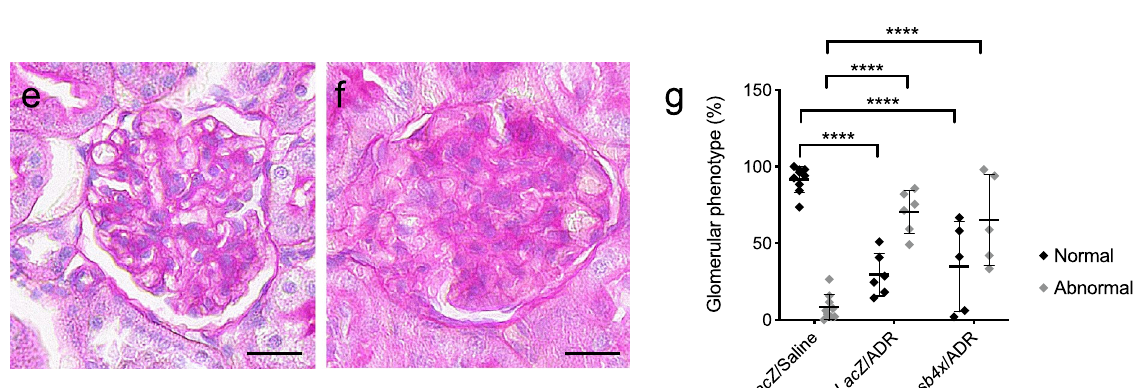
Figure 3. Renal function following ADR/TB4 treatment. (a) Mouse weight change 2, 7 and 14 days after ADR/ vehicle injection. Statistical annotations (two way repeated measures ANOVA with Tukey post hoc test) using asterisk refer to comparison between LacZ /saline & LacZ /ADR. Annotations using hash refer to comparison between LacZ /saline & Tmsb4x /ADR. (b) Twenty-four hour urinary albumin excretion 0, 2 and 14 days after ADR/vehicle injection (two way repeated measures ANOVA with Tukey post hoc test). (c) Correlation of plasma TB4 concentration with urinary albumin 14 days after ADR injection (Linear regression, R 2 = 0.4584, P ≤ 0.05). (d) Blood urea nitrogen concentration 14 days after ADR/vehicle injection (one-way ANOVA with Tukey post hoc test). Representative images of normal (e) and abnormal (f) glomeruli used to assess glomerular morphology, scale bar = 20 μm. (g) Glomerular phenotype 14 days after ADR/vehicle injection. Results for each category are expressed as a percentage of the total glomeruli assessed. LacZ /saline, n = 9; LacZ /ADR, n = 6; Tmsb4x /ADR, n = 5. Data are presented as the mean ± SEM; * P ≤ 0.05, ** P ≤ 0.01, *** P ≤ 0.001 and **** P ≤ 0.0001. TB4, Tmsb4x, thymosin β4; ADR, Adriamycin; LacZ , TB4 prevents ADR‑induced podocyte injury in vivo.